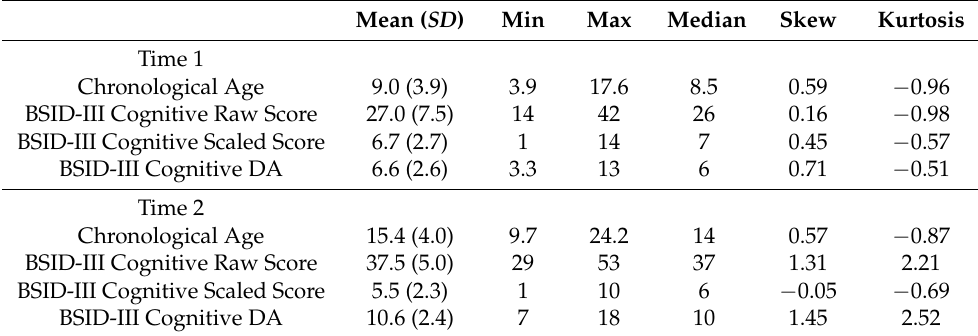
Table 1. Infant BSID-III characteristics at Time 1 and 2, n =